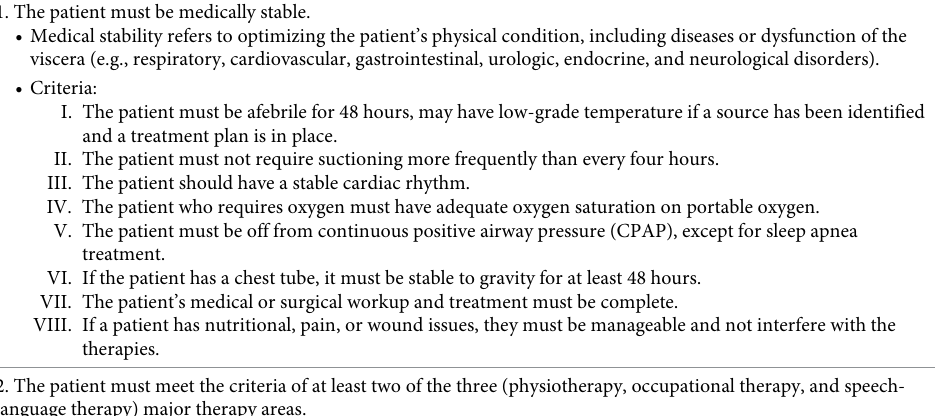
Table 1. Patient selection criteria for